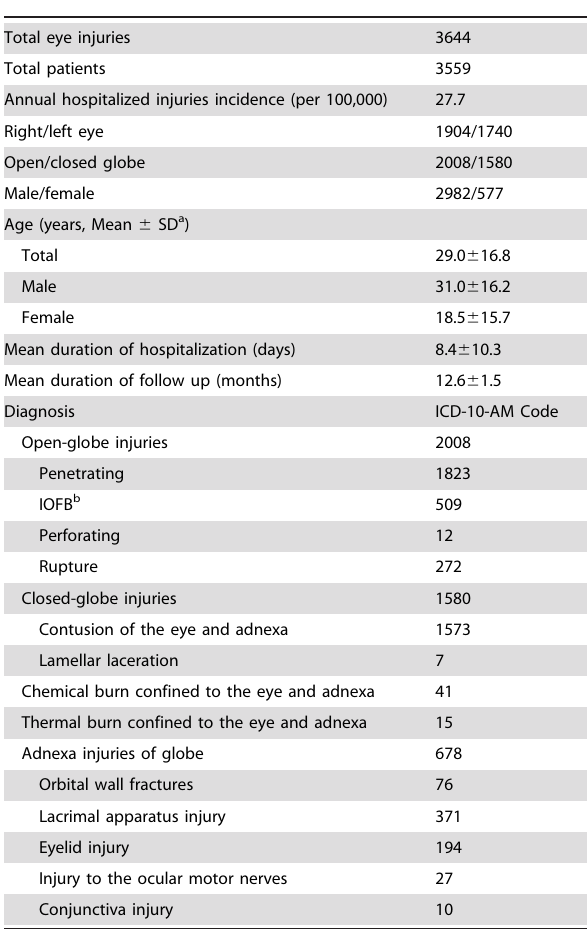
Table 1. Characteristics of patients hospitalized with eye injury diagnoses over a 10-year period (1stJanuary 2001– 31stDecember